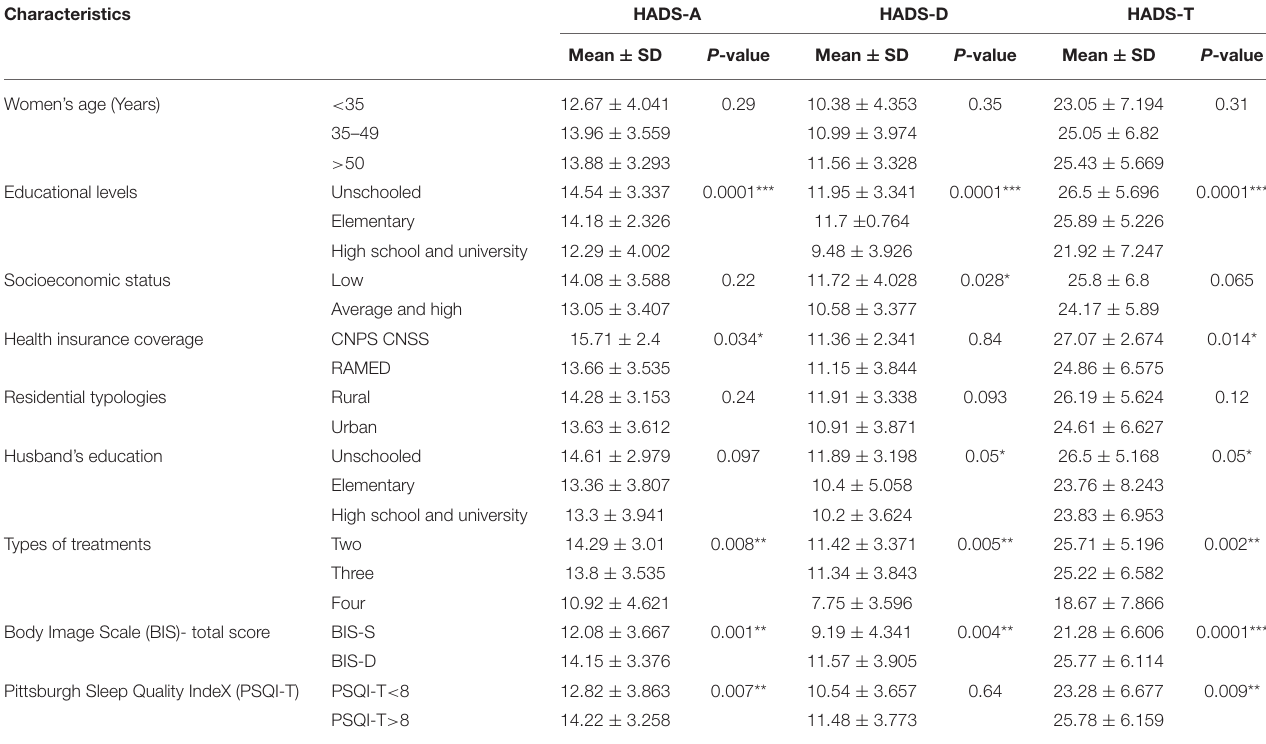
TABLE 2 | Comparison between the Hospital Anxiety and Depression scale components (HADS-A, HADS-D, HADS-T) and both demographic and clinicopathological characteristics.